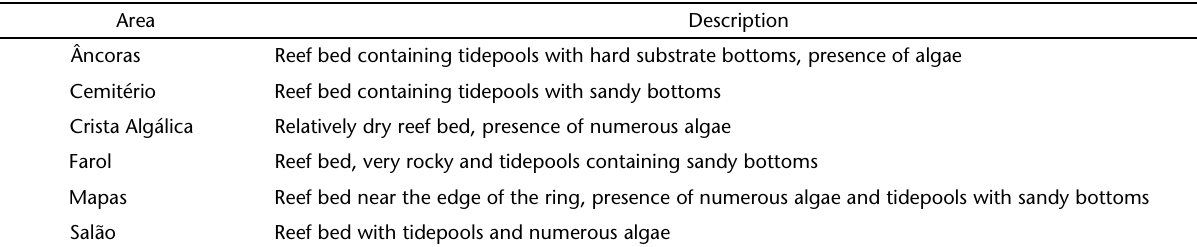
Table I. Description of habitats of the six sampled areas in Rocas